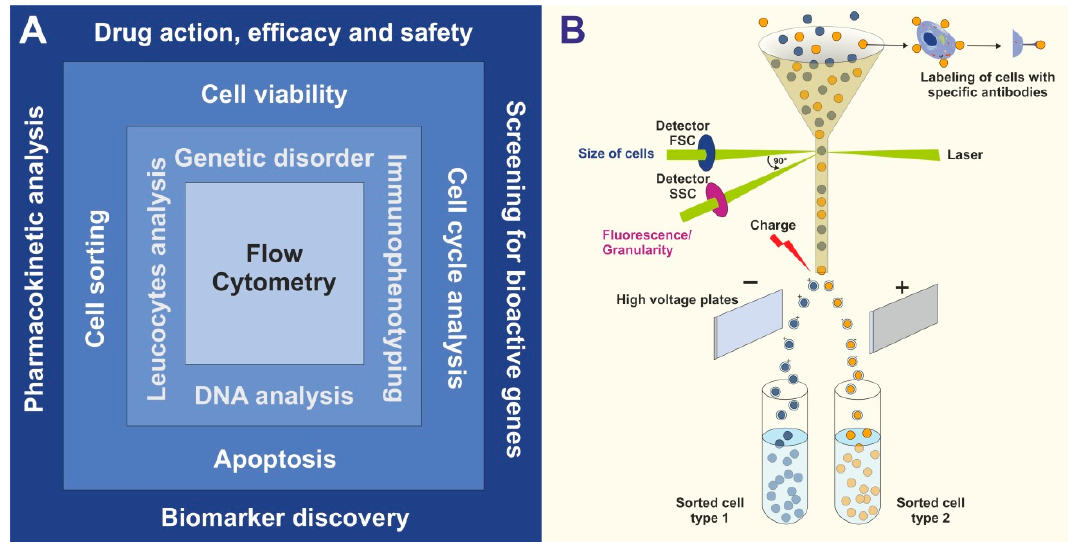
Figure 1. Fields of application and principle of FACS analysis. ( A ) In basic research and clinical routine, FACS is used for many applications including general cell sorting, cell cycle analysis, cell viability testing, apoptosis testing, immunophenotyping, DNA analysis, blood cell analysis, and determination of genetic disorders. ( B ) The cell solution is passed through a narrow channel and cells are subjected to light pulses detected by the forward scattered (FSC) and side scattered (SSC) detectors, which are generated by the transit of the cell through a constant laser source in the flow channel. Besides the characteristics of cells that can already be discriminated by their FSC and SSC profiles, the additional staining with fluorescently-labeled antibodies provides more detailed and specific discrimination between different cell types of interest.